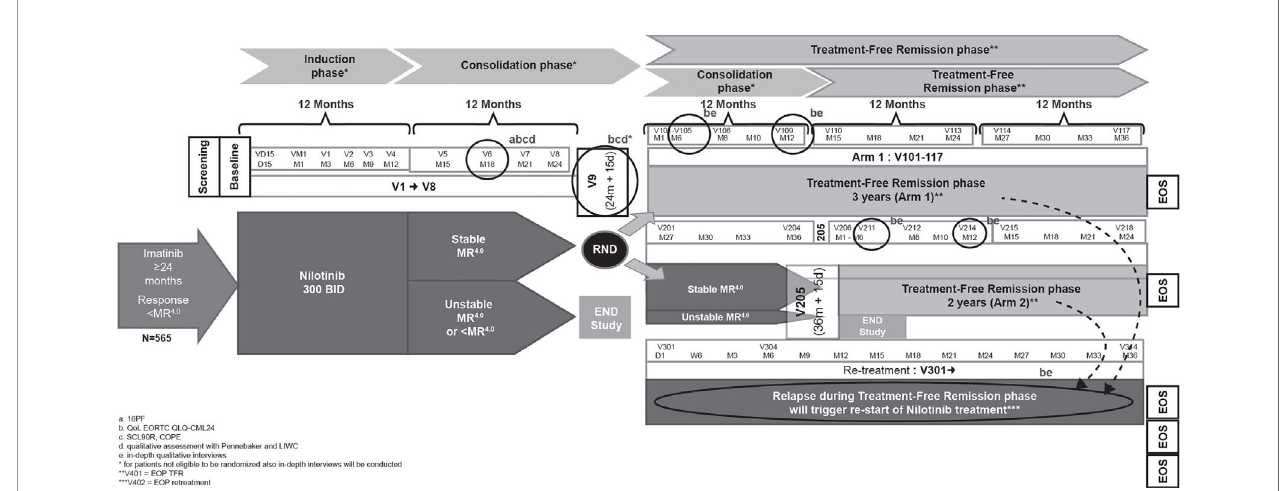
FIGURE 1 | ENESTpath Italian sub-study